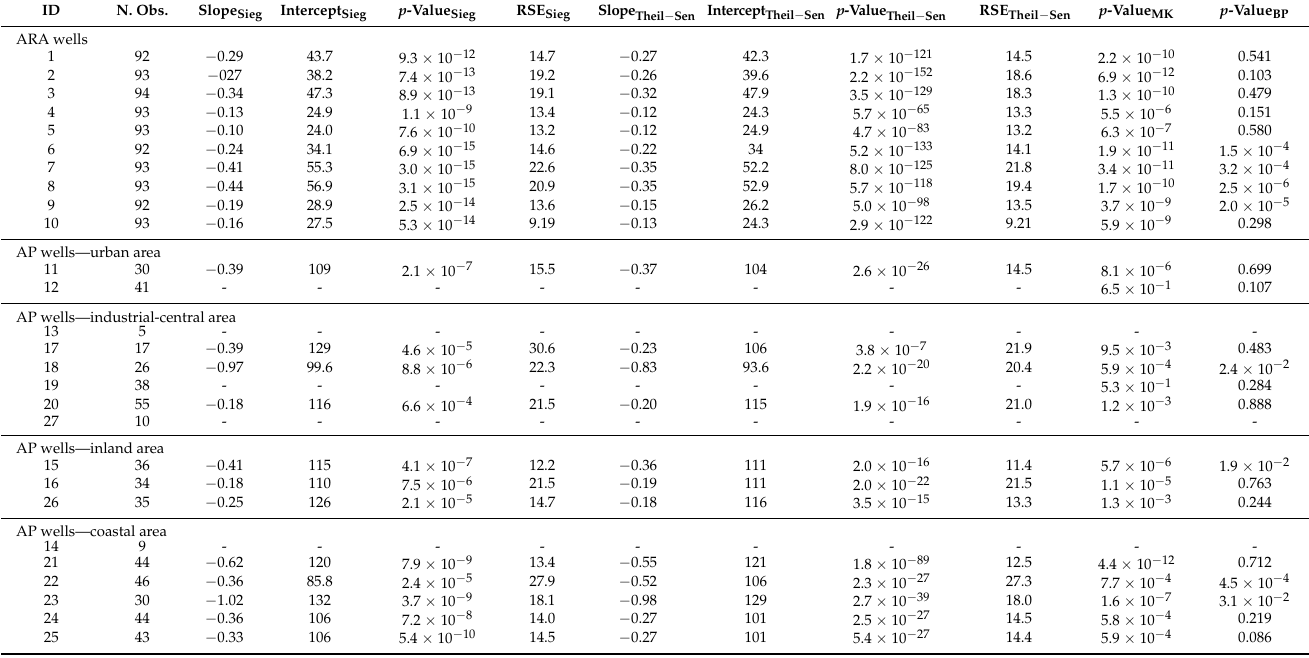
Table 3. Results of the linear fitting analysis. The following parameters are reported: well ID; total number of available measurements (N. Obs.); median-based Siegel test parameters (Slope Sieg , Intercept Sieg , p -value Sieg , Residual Standard Error = RSE Sieg ); Theil-Sen single median test parameters (Slope Theil-Sen , Intercept Theil-Sen , p -value Theil-Sen , RSE Theil-Sen ); p -values of the Mann-Kendall test ( p -value MK ) and Breusch–Pagan test ( p -value BP ).